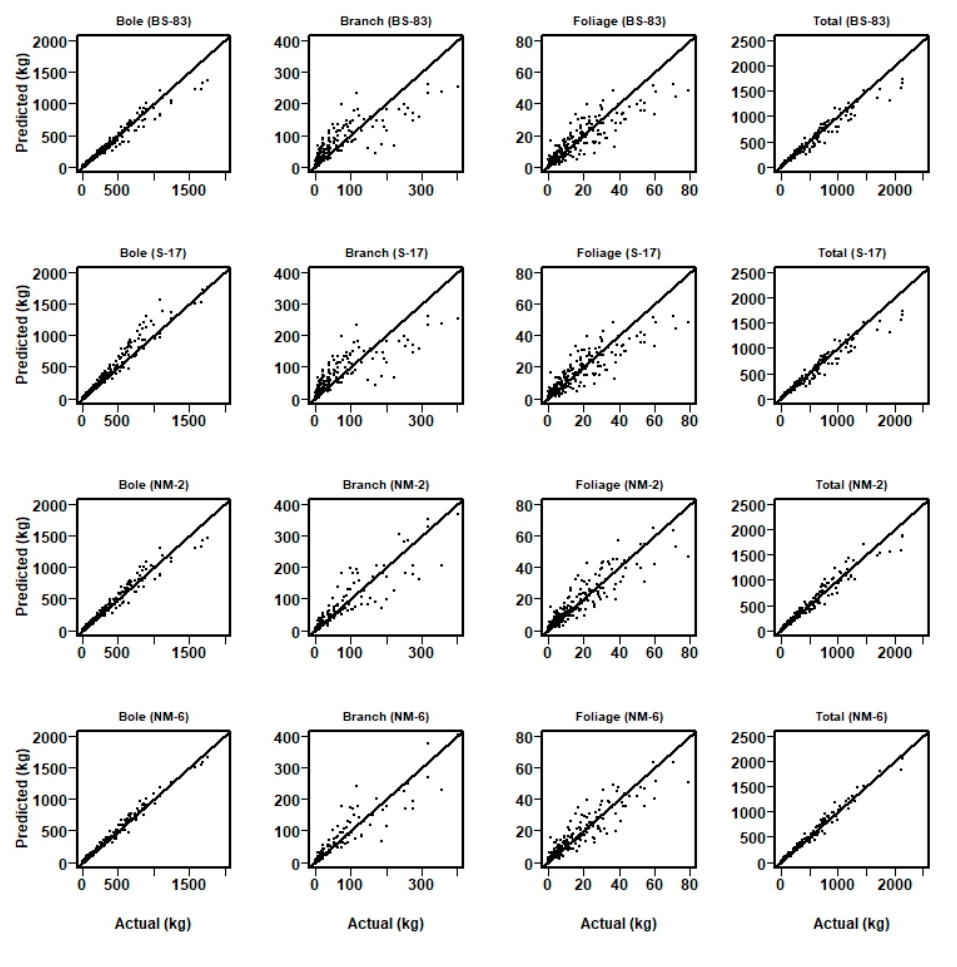
Figure 5. Comparison of each component and total biomass with the model systems II (NM-2) and VI (NM-6), and previously published biomass equations of Baldwin and Saucier [8] (BS-83) and Samuelson et al. [19]